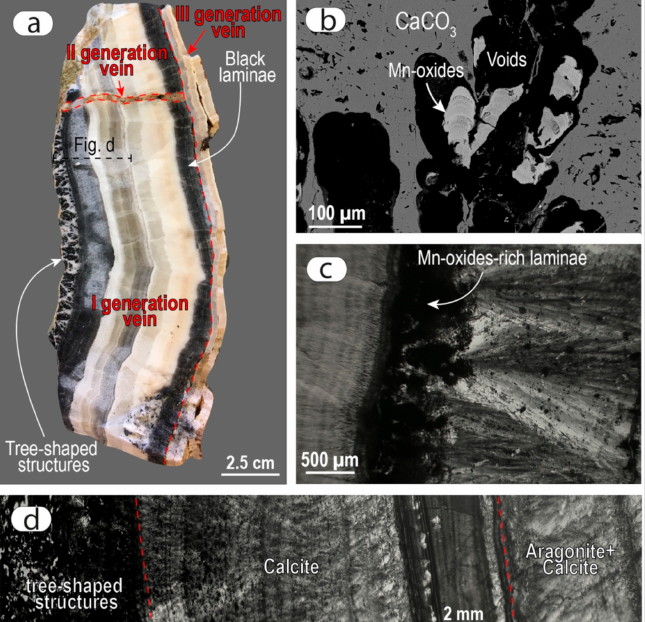
Figure 15. ( a ) Example of a banded Ca-carbonate vein composed by three superimposed veins; ( b ) SEM image of the Mn-oxide lamina characterized by a subrounded shape of different shades of gray. Brighter gray suggests a higher Mn-oxide concentration. ( c ) Micrograph (crossed polars) showing detail of Mn-rich laminae. ( d ) Micrograph (crossed polars) of a PAM1 sample showing bands made up of calcite and (Sr)-aragonite (from [36],